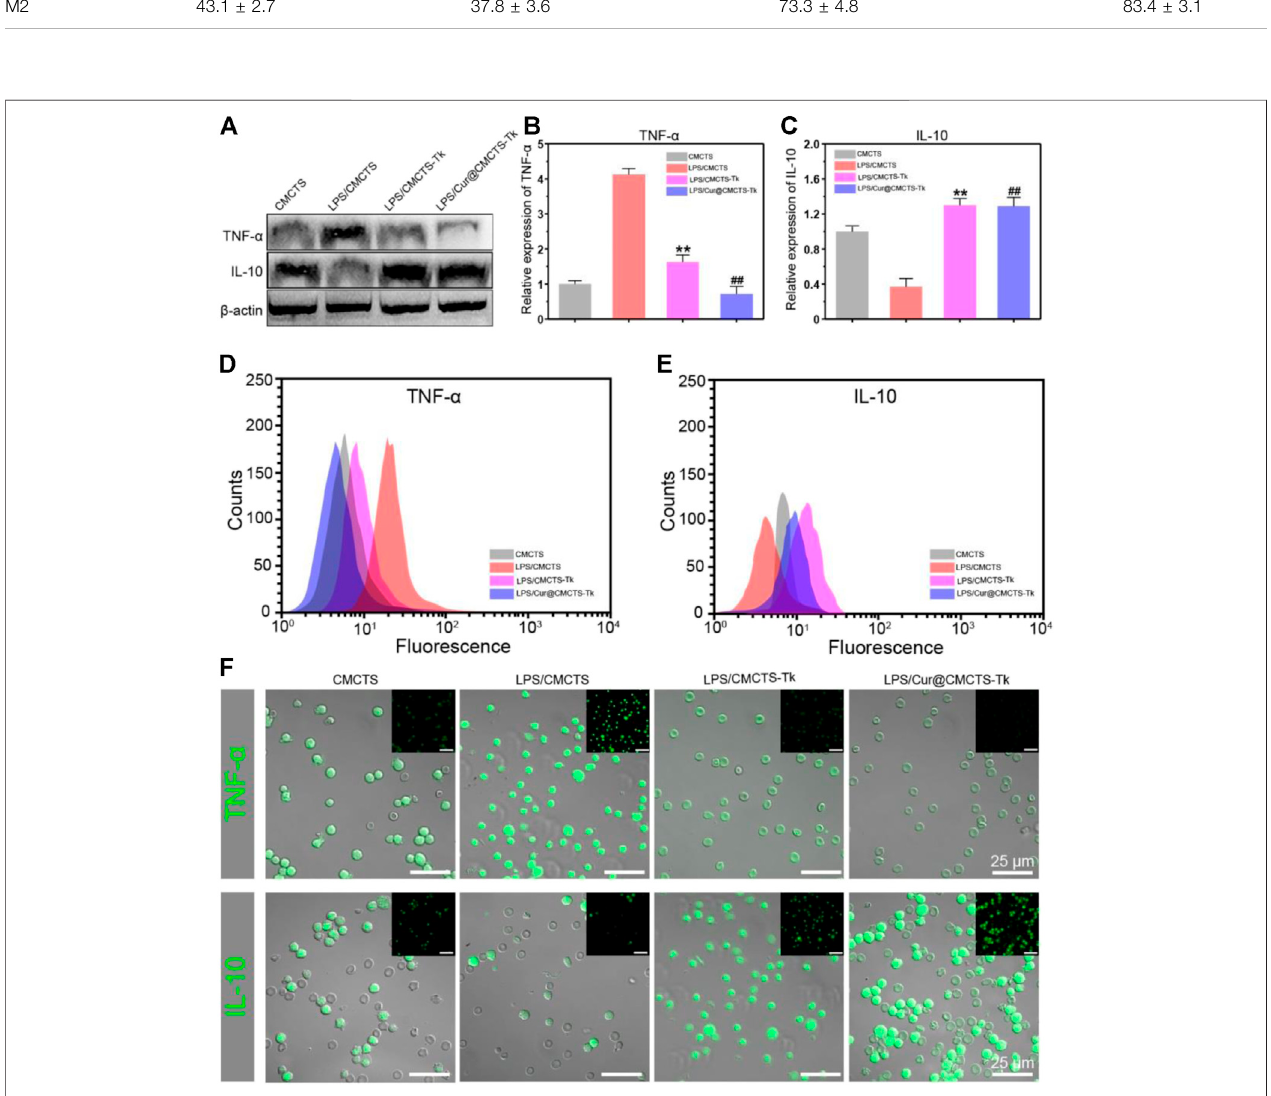
FIGURE 6 | The protein expressions in RAW cells cultured with normal CMCTS hydrogel (control) and LPS/CMCTS (LPS), LPS/CMCTS-Tk, and LPS/Cur@ CMCTS-Tk hydrogel after 24 h were analyzed using Western blot (A) and the TNF- α (B) , IL-10 (C) relative expression analysis. The FCM analysis (D – E) and immuno fl uorescencestaining (F) ofTNF- α andIL-10inRAWcells.Thedatawererepresentedasmean ± SD( n (cid:2) 3).** p < 0.01vs.control; ## p < 0.01vs.LPSgroup.The scale bar is 25 μ